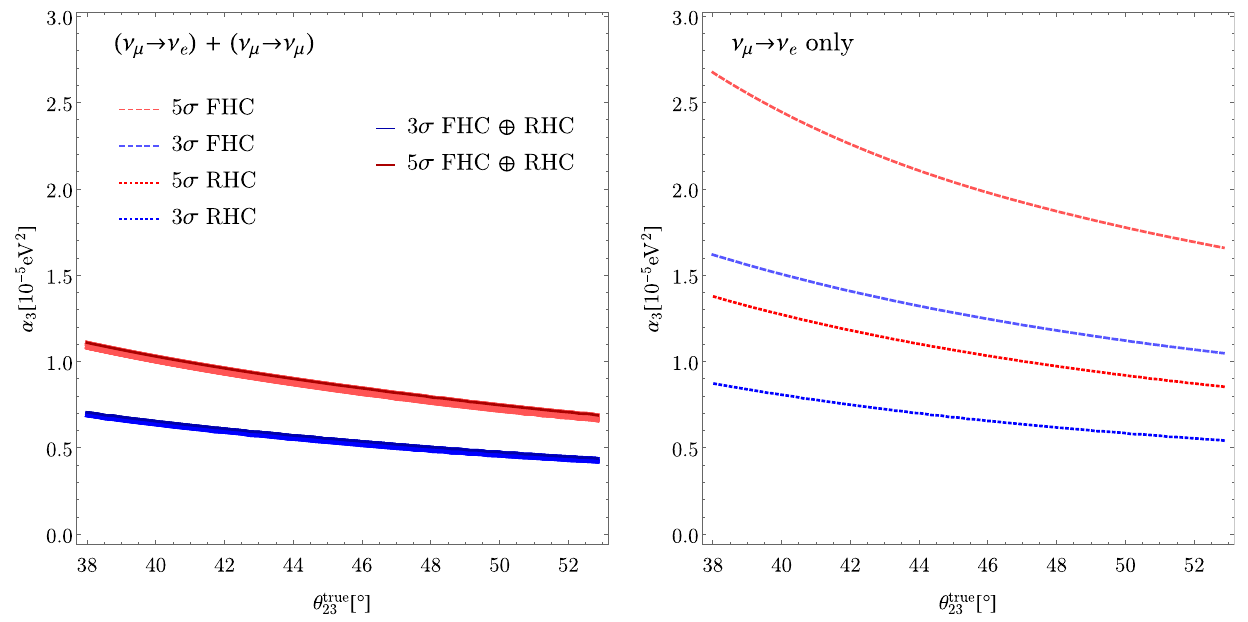
δ true . Left: the sensitivity when , with the shaded area below giving the sensitivity for fixed val- 23 CP ues of the phase. Right: sensitivity curves for only FHC or RHC runs, including only the ν e appearance channel